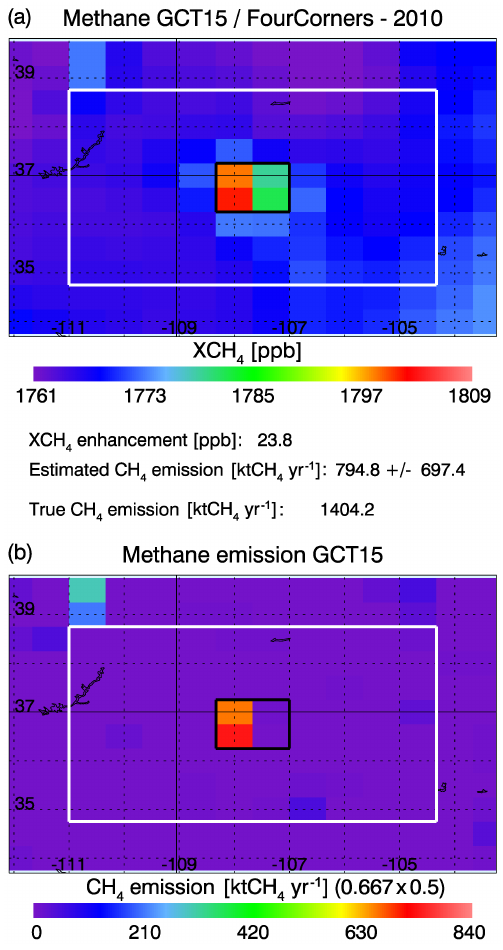
Figure 12. As Fig. 9 but for the Four Corners region (see main text for